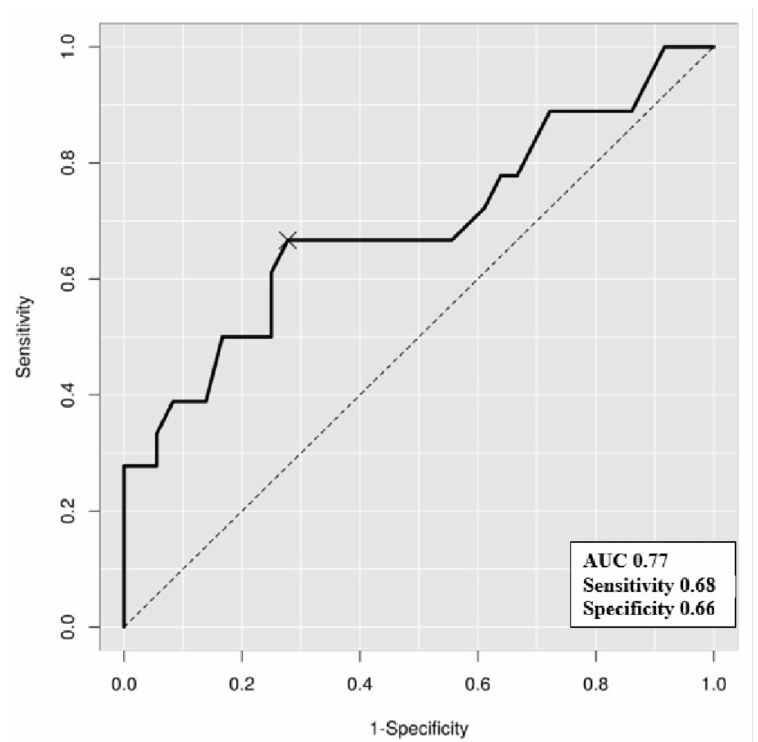
Figure 2. Receiver operating characteristic (ROC) curve of glycosylated hemoglobin and plasma kidney injury molecule-1 greater than 23.10 pg/mL. The area under the curve (AUC) was 0.77 and the optimal cutoff point (sensitivity, specificity) was 6.75% (0.68,